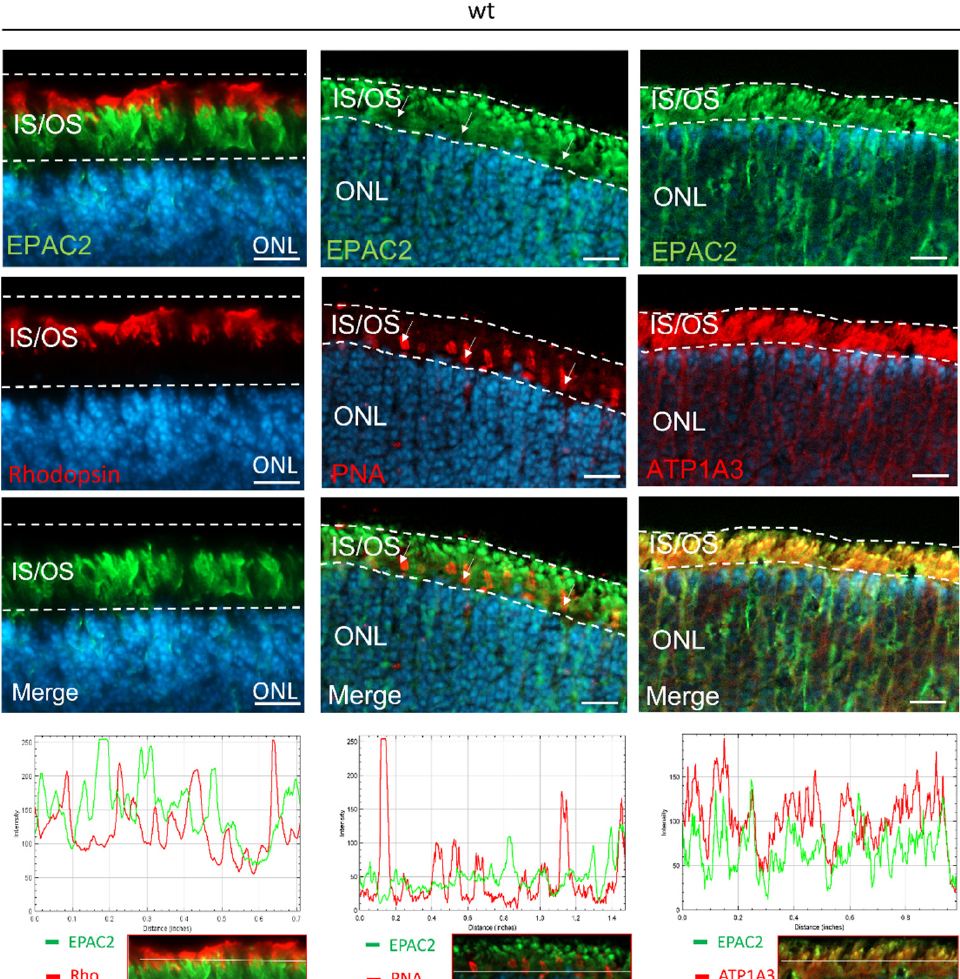
Figure 1. EPAC2 protein localization in wt retina. Panels show, from top to bottom, EPAC2 staining, photoreceptor markers, merged images, and fluorescence intensity profiles*. ( Left panel ) EPAC2 was expressed in the outer nuclear layer (ONL) and within photoreceptor segments (IS/OS), but there was no overlap between EPAC2 and rhodopsin, a marker for rod outer segments (OS); ( Middle panel ). There was no clear indication of colocalization between EPAC2 and peanut agglutinin (PNA, a specific glycoprotein binder that binds the extracellular matrix around the inner segments (IS) and OS, as well as the synaptic pedicles, of cones [Blanks and Johnson, 1984 [32], Johnson et al., 1986 [33]). Arrows show PNA localization; no clear colocalization is observed between PNA and EPAC2, which is further supported by the fluorescence intensity profile at the bottom. ( Right panel ) Overlap between EPAC2 and ATP1A3, a protein specific for photoreceptor IS (Molday, LL et al., 2019 [34]), as indicated by the merged picture and fluorescence intensity profiles. The pictures represent three biological replicates per staining. DAPI (blue) was used as a nuclear counterstain. Scale bar: 10 µm. * Fluorescence intensity profiles were obtained by analyzing a horizontal line (indicated by a white line in the bottom pictures) in the segments and showing the intensities of the respective green/red fluorescence in a graph.